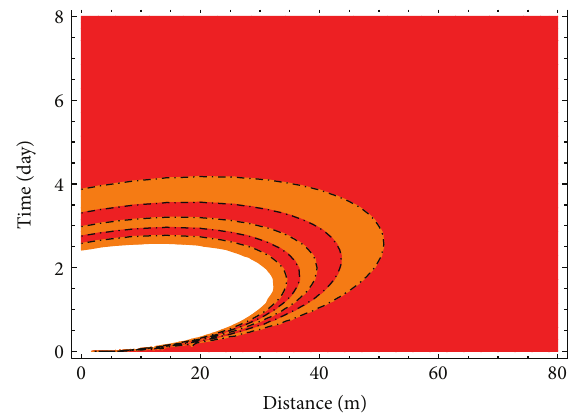
Figure 18: Numerical simulation of the plume as function of space (m) and time (day).